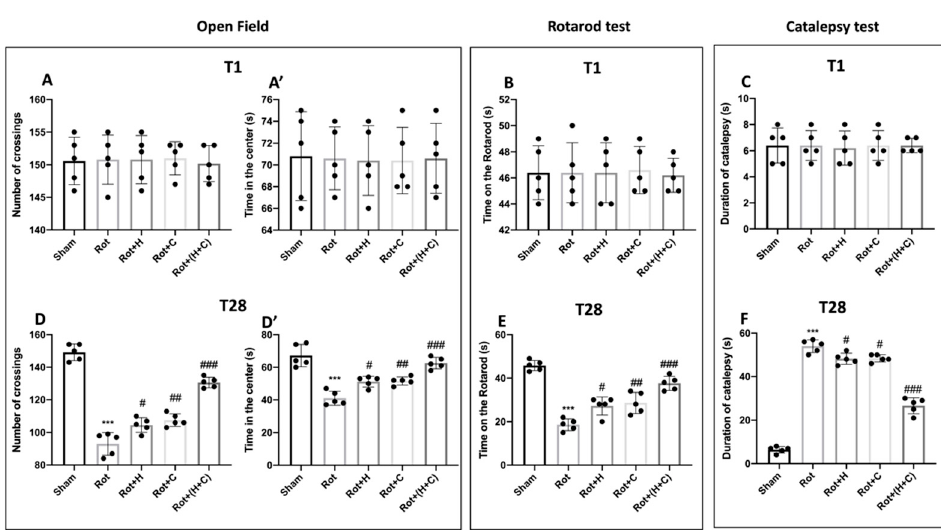
Figure 7. Effect of H or C or H+C on behavioral motor alterations in Rot-lesioned mice. Motor function was assessed using OF ( A , A’ for T1 and D,D’ for T28), RT ( B for T1 and E for T28) and CT ( C for T1 and F for T28). The data are expressed as the mean ± SD of 5 mice for each group. *** p < 0.001 compared to Sham; # p < 0.05 compared to Rot; ## p < 0.01 compared to Rot; ### p < 0.001 compared to Rot.